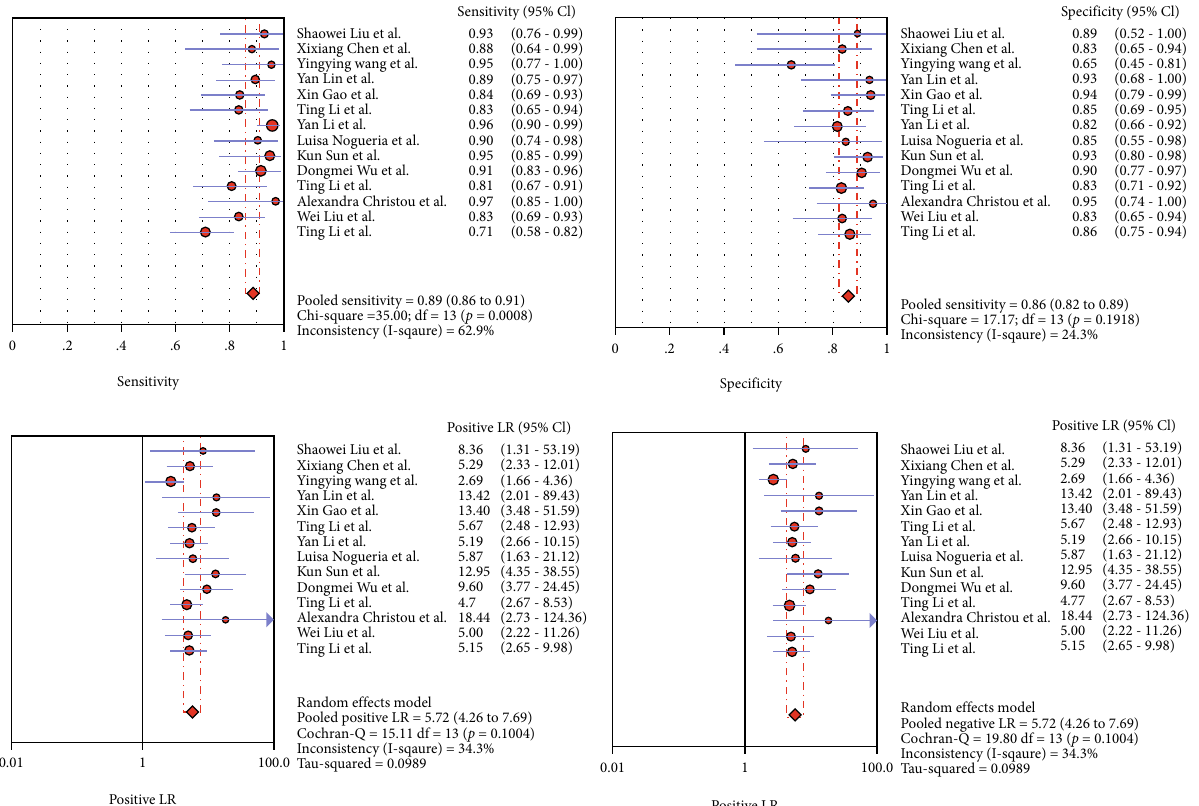
Figure 5: Forest plots of pooled sensitivity, pooled speci fi city, positive LR, and negative LR for MK in detecting benign and malignant breast lesions. LR: likelihood ratio; MK: mean